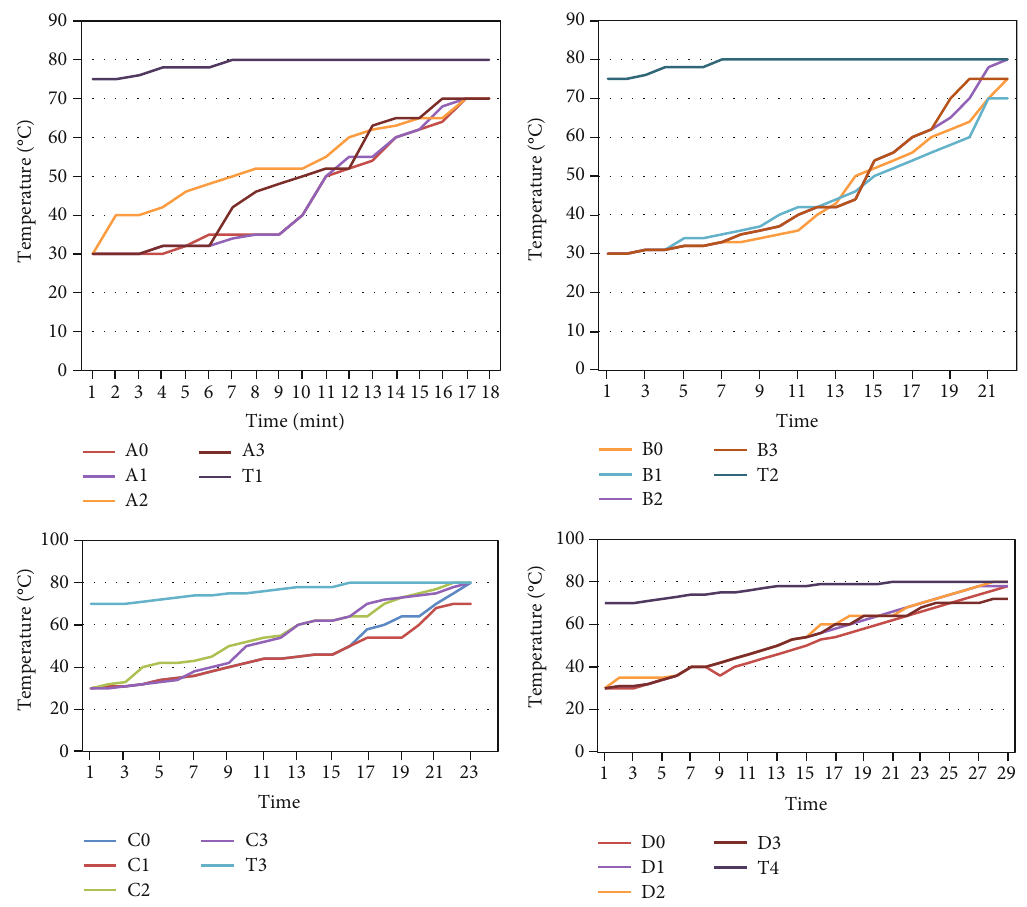
Figure 4: Phase change material temperature variation with time throughout melting time process based on di ff erent radial and axial locations along with the vertical latent heat thermal storage.